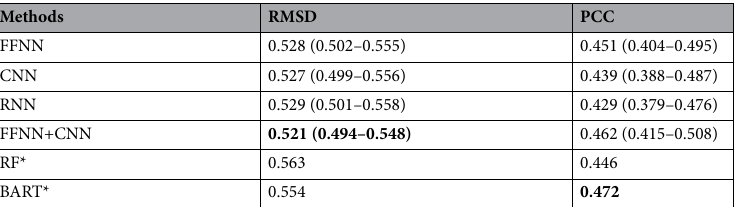
Table 2. ALSFRS slope prediction performance. RMSD and PCC are shown for all methods. FFNN, CNN, and RNN performance was obtained on the external test set (n = 731) using 10,000 bootstrap with resampling. For these predictors we reported the mean and the 95% confidence interval (CI). FFNN+CNN represents the ensemble prediction of the two neural networks. The best values for each metric are highlighted in bold. *Random Forest (RF) and Bayesian Additive Regression Trees (BART) are taken from literature 31 , where they are reported without